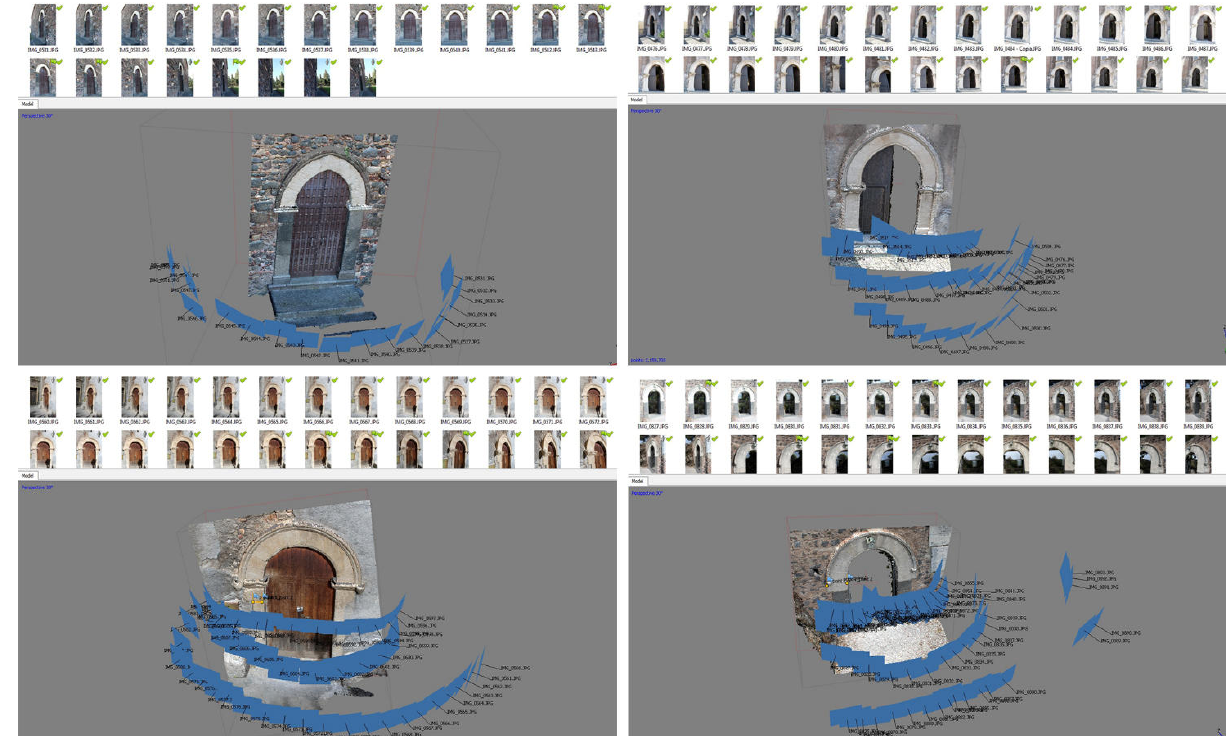
Figure 2. View of the datasets and image pose reconstruction